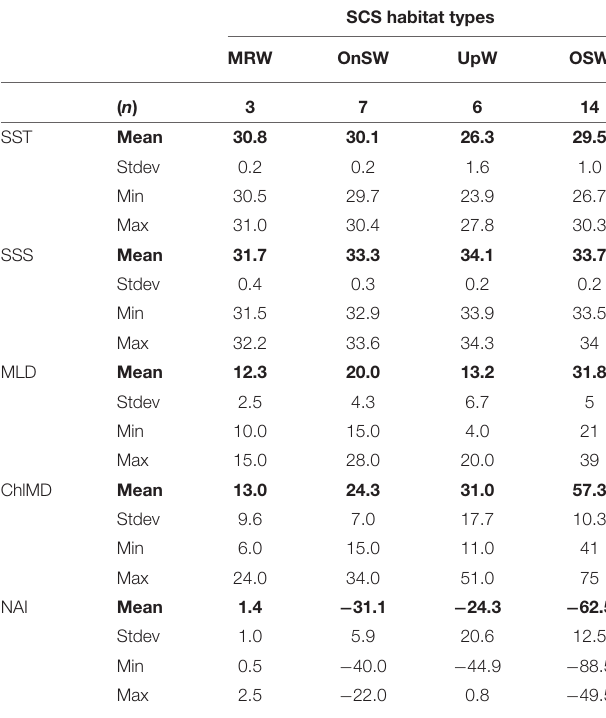
TABLE 1 | Summary of environmental variables used to define habitat types in the Western Tropical North Atlantic (WTNA). WTNA habitat types